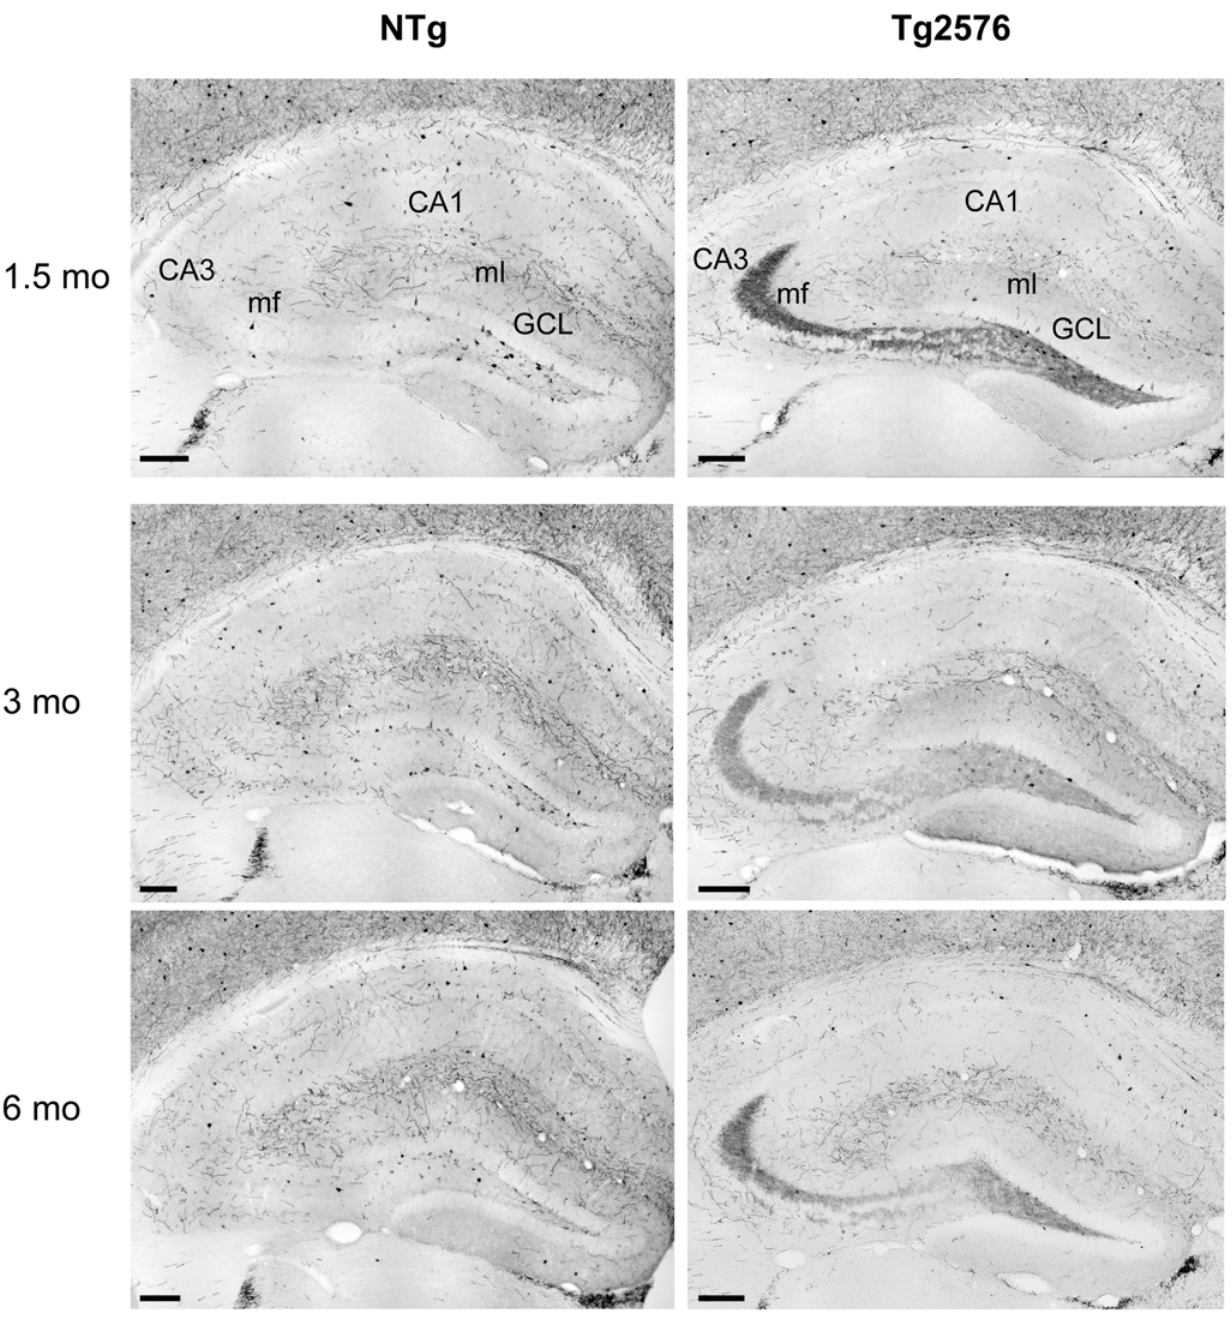
Fig 3. Ectopic expression of NPY in the mossy fibers of young Tg2576 mice. Photographs of the dorsal hippocampus immunostained for NPY in 1.5, 3 and 6 month-old non-transgenic (NTg) and Tg2576 mice. Left: In NTg animals, NPY staining is visible in the soma of hilar interneurons. Their axons display a faint staining visible in the molecular layer (ml), where these axons form synapses onto the dendrites of granular cells. Right: Typical ectopic NPY expression in the mossy fibers (in hilus and stratum lucidum ) of a Tg2576 mouse. CA1 and 3, Cornu Ammonis 1 and 3, GCL: Granular Cell Layer, mf: mossy fibers, ml: molecular layer. Scale bar: 200 μ